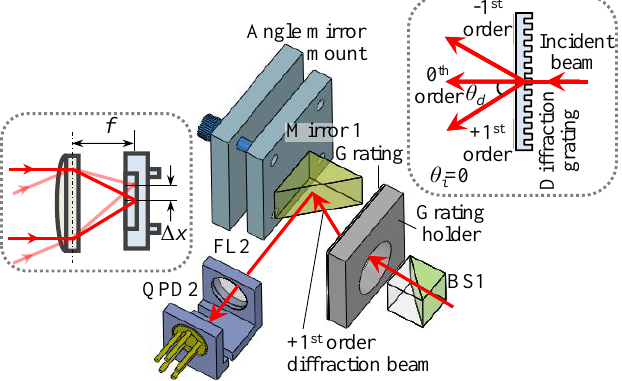
Figure 4. Optical layout of the wavelength corrector kit.